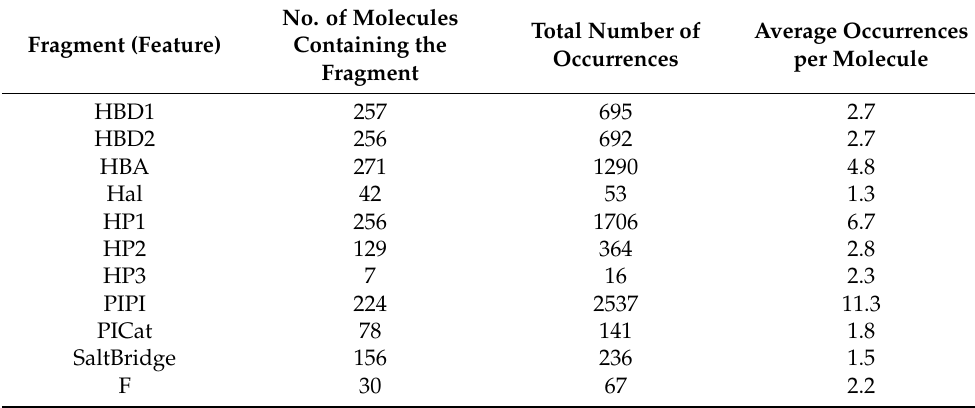
Table 1. Number of molecules, containing specific fragments.